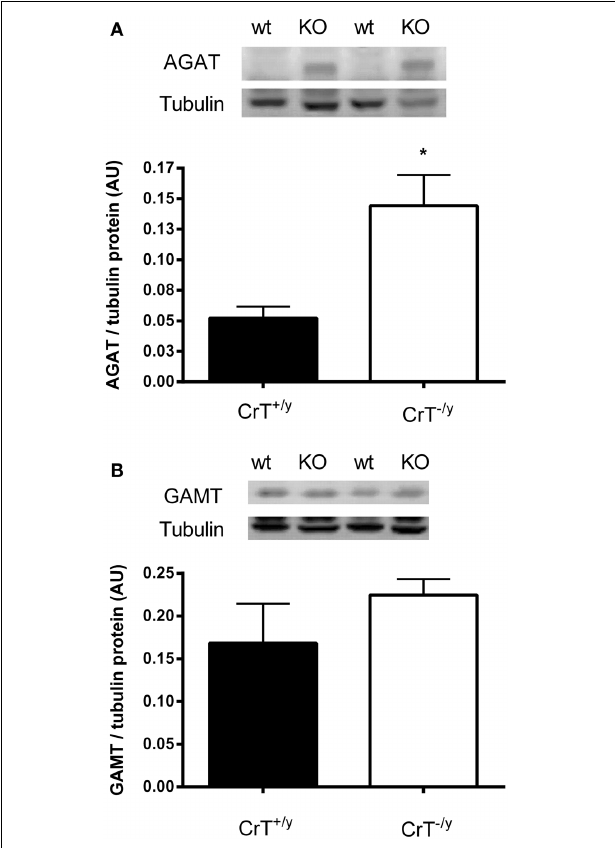
FIGURE 2 | (A) AGAT and (B) GAMT protein expression in CrT + / y and CrT − / y gastrocnemius mice muscle. Values are means ± s.e.m., n = 6 per group. Different from CrT + / y ∗ P < 0 . 05.